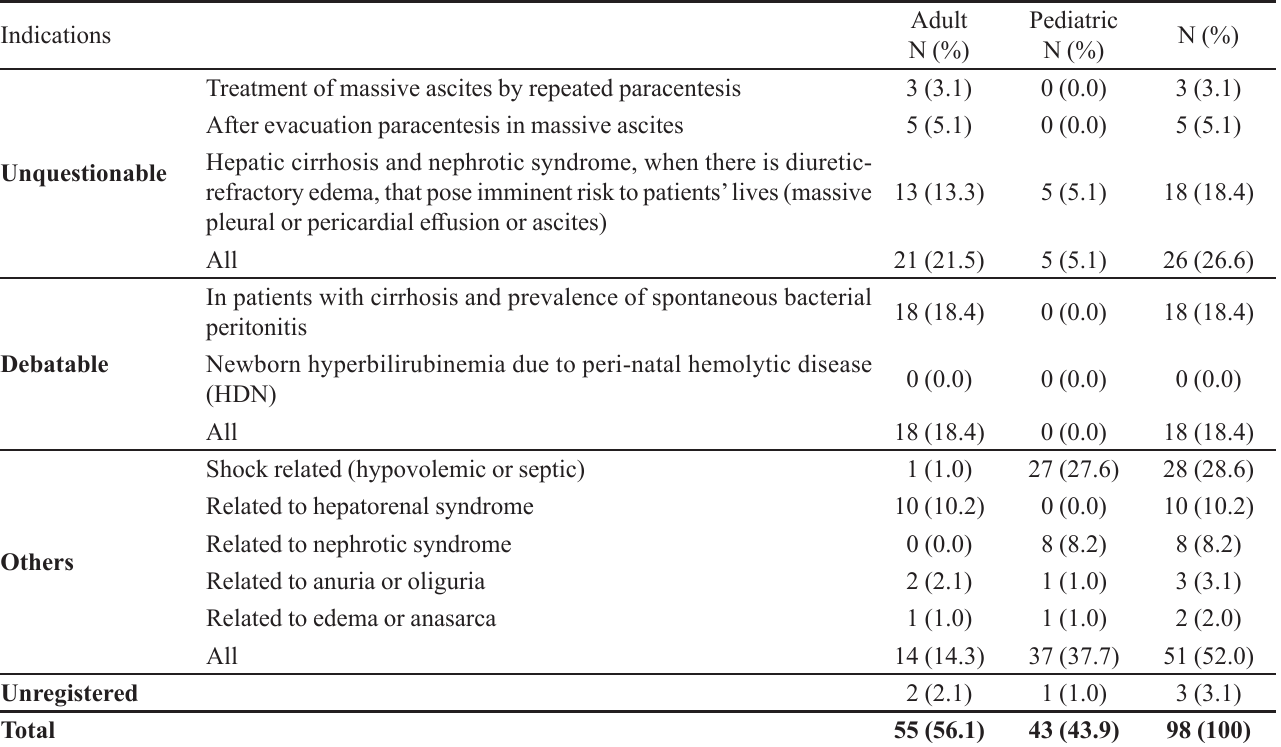
TABLE III - Indications marked in the request form for human albumin use (HU-USP, from January to October 2017) Indications